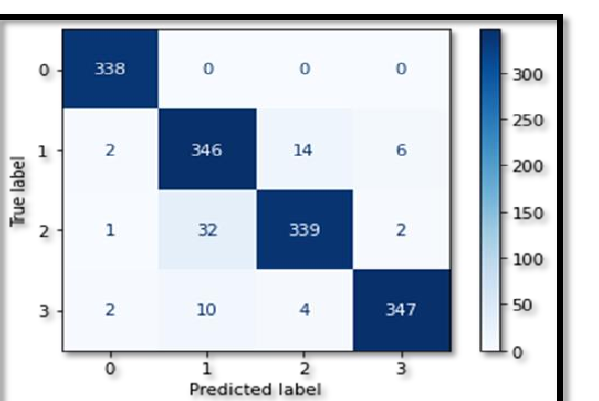
Fig. 10 . Confusion matrix for Corn dataset